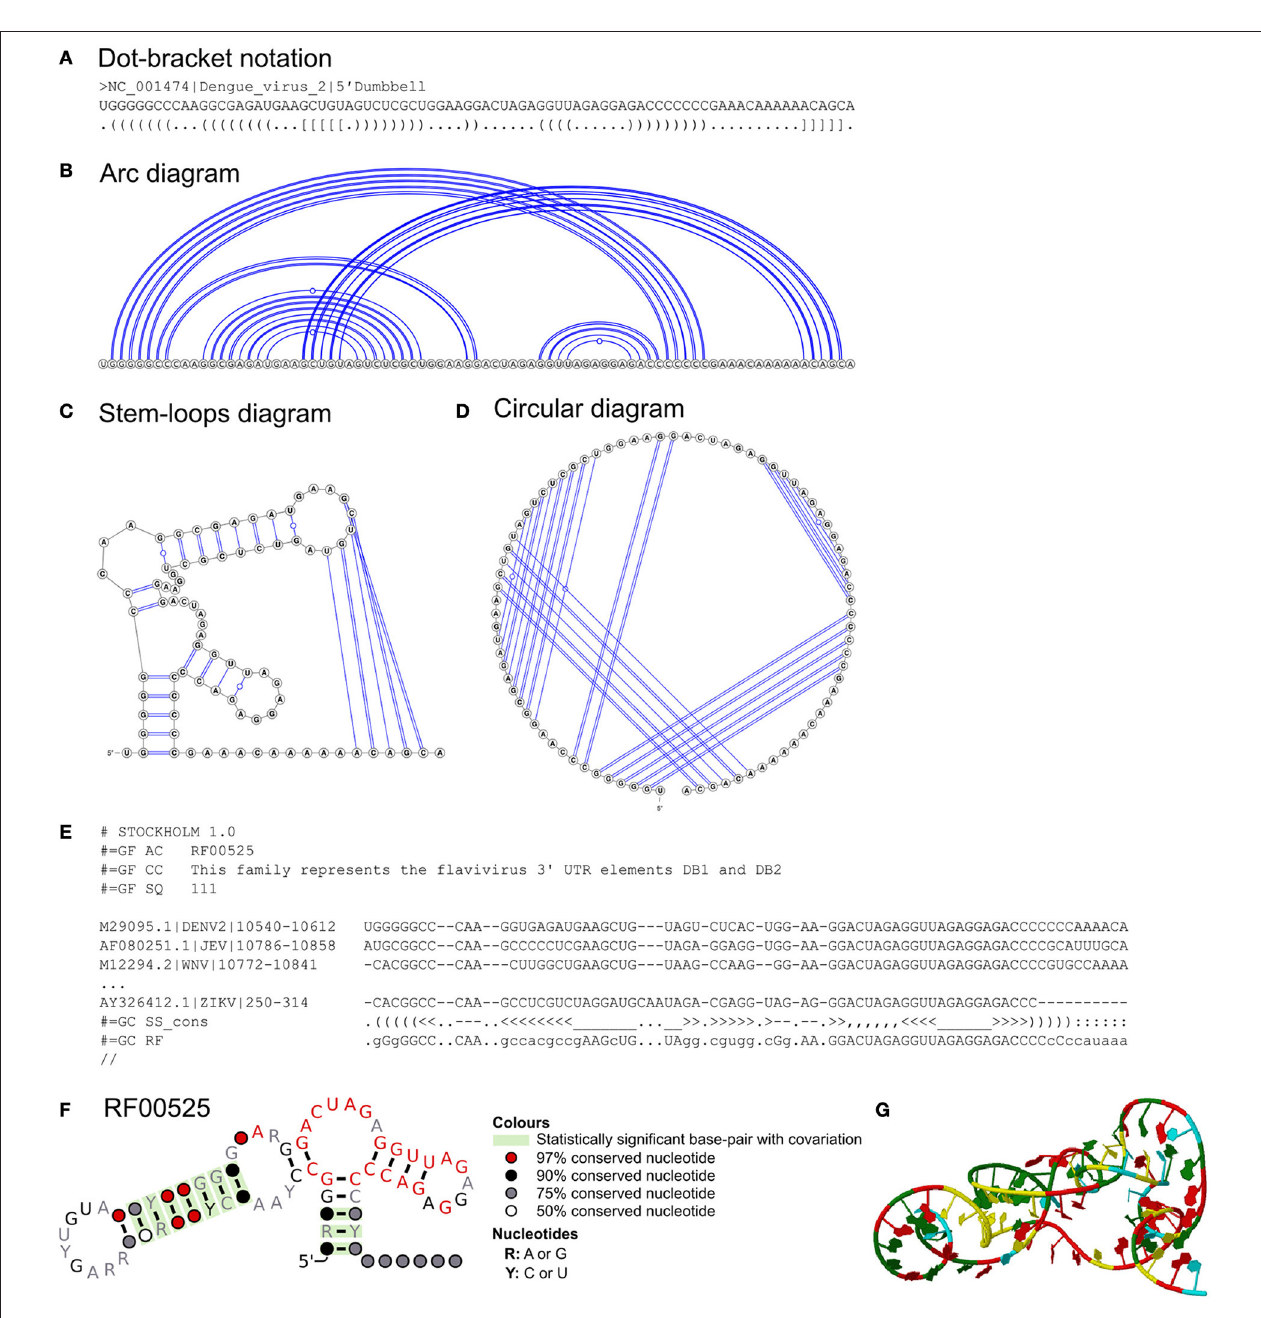
FIGURE 2 | Dumbbell RNA structures of flaviviruses. Representations of 5 ′ dumbbell of dengue virus 2 in (A) dot-bracket notation, (B) arc, (C) stem-loops, and (D) circular diagrams. The diagrams are illustrated by VARNA (with pseudoknotted interactions). (E) The excerpts of the Stockholm file of the dumbbell elements (both 5 ′ and 3 ′ dumbbells) from Rfam. A Stockholm file consists of descriptions of the RNA structure of interest, multiple sequence alignment and consensus secondary structure in dot-and-bracket format. (F) Rfam model of the dumbbell structure assessed and illustrated by R-scape and R2R, respectively. (G) Representations of 5 ′ dumbbell of dengue virus 2 in 3D structure (modeled by SimRNAWeb; Magnus et al.,